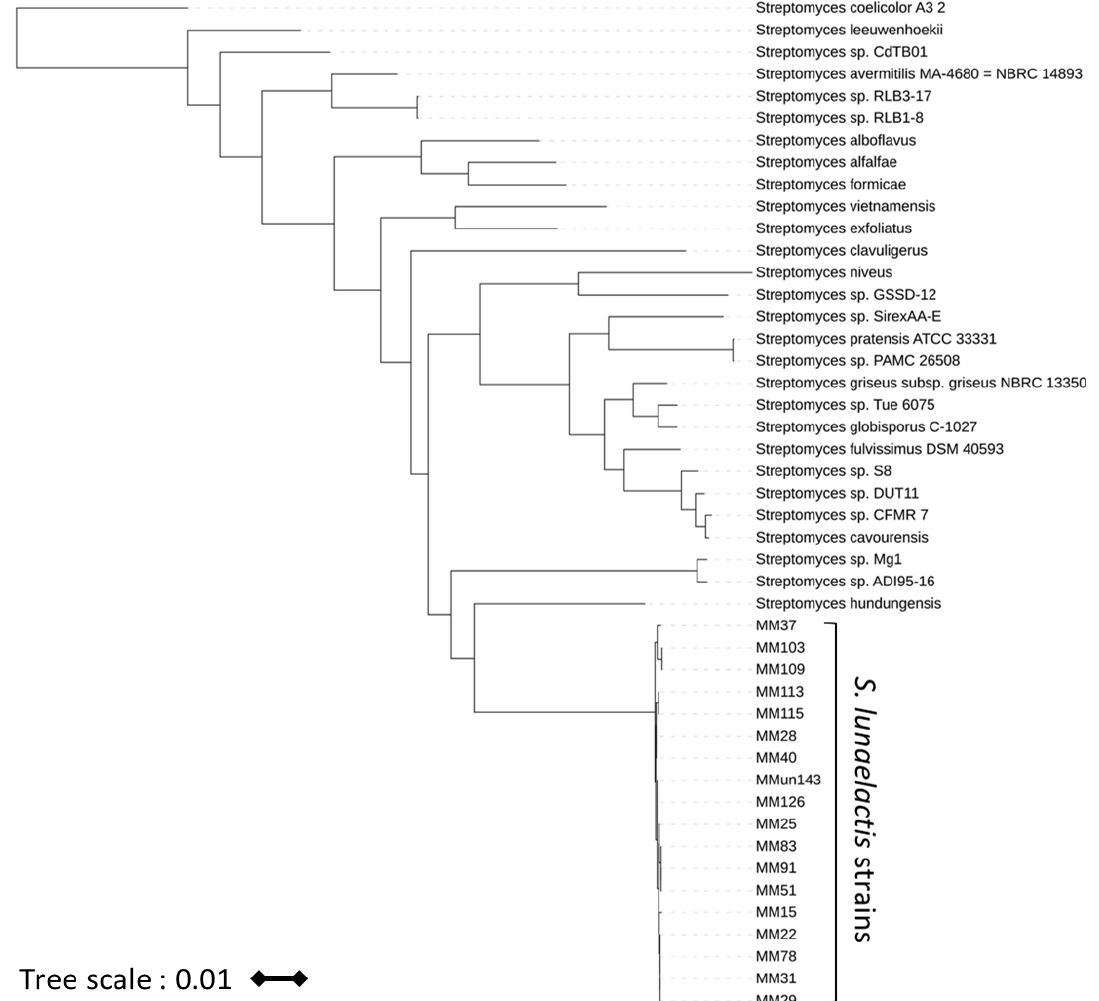
Figure 1. Maximum likelihood phylogenetic tree of S . lunaelactis strains and their closest Streptomyces counterparts. The tree was generated on concatenated sequences of atpD-gyrB-recA-rpoB-trpB . The tree is rooted on Streptomyces coelicolor , used as the outgroup, and the tree bar indicates 1% of the estimated sequence divergence.